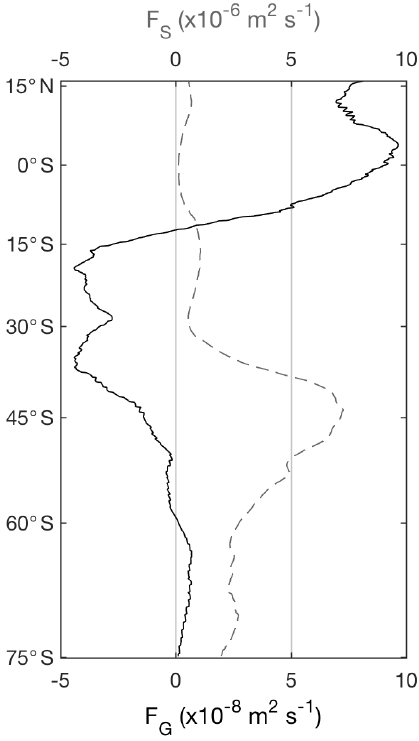
Figure 7. The zonal mean surface buoyancy ( F G , solid line) and shear ( F S , dashed line) fluxes from OceanMAPS version 3.0. A positive (upwards) buoyancy flux tends to make the mixed layer unstable and promote mixing.